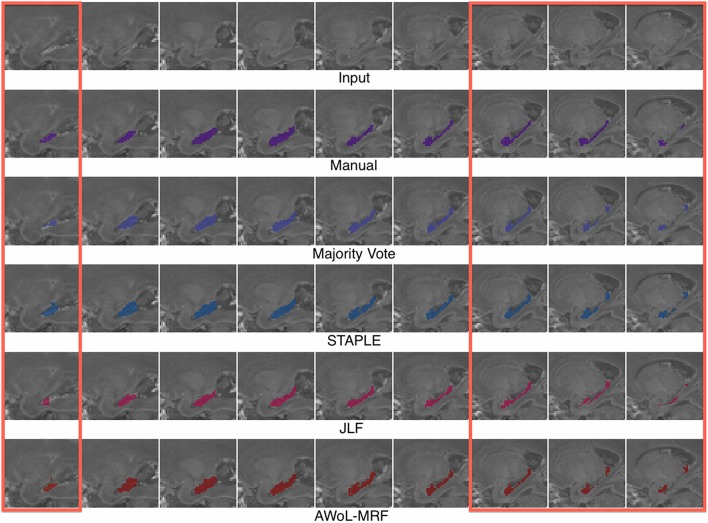
Experiment III Qualitative Analysis: Comparison of manual vs. automatic segmentation methods. The red rectangles illustrate sections where the superiority of the AWoL-MRF approach is particularly apparent. The segmentations are performed using three atlases, and the Dice scores are as follows: majority vote: 0.748, STAPLE: 0.760, JLF: 0.746, AWoL: 0.807. The segmentation of the left hippocampus is shown in sagittal view. Note that for this particular dataset, the brain structures are mostly unmyelinated causing a reversal of the intensity values for the hippocampal structure—as shown in the top row.